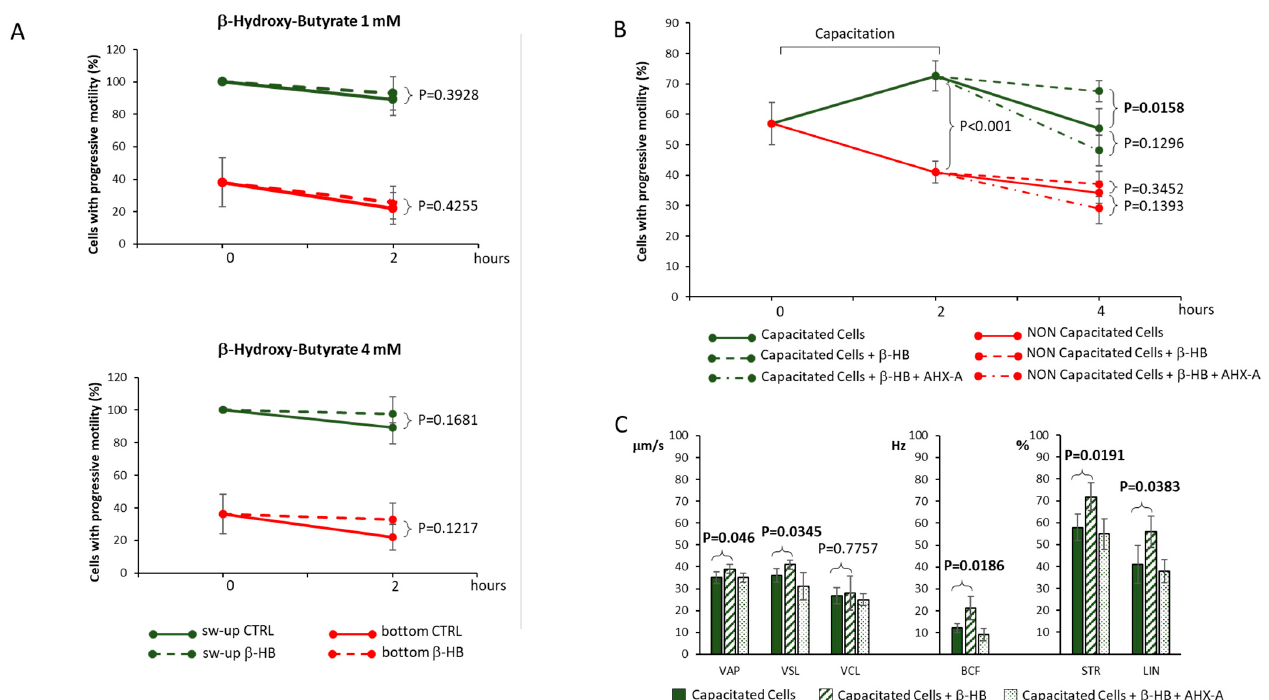
Figure 1. ( A ) Effect of 2 h exposure to 1 mM or 4 mM β -hydroxy-butyrate ( β -HB, dashed lines), on cell progressive motility, in sperm cells from normozoospermic subjects, isolated according to their highly migratory (sw-up, green lines) or low migratory (bottom, red lines) activity in a swim-up procedure. Continuous lines refer to β -HB-lacking controls. Results show the mean values of 4 independent experiments. ( B ) Effect of 2 h exposure to 4 mM β -HB (dashed lines) on cell progressive motility, in sperm cells undergone to capacitation (green lines) or non-capacitated controls (red lines). Point line traits refer to experimental conditions involving exposure to β -HB and the succinyl-CoA transferase inhibitor aceto-hydroxamic acid (AHX-A). ( C ) Sperm motility parameters, evaluated with a Sperm Class Analyzer (CASA), in capacitated sperm cells maintained for 2 h in capacitating medium, in capacitating medium with the addition of 4 mM β -HB, or in capacitating medium with the addition of 4 mM β -HB and AHX-A. CASA parameters included average path velocity (VAP), straight-line (rectilinear) velocity (VSL), sperm curvilinear velocity (VLC), beat-cross frequency (BFC), straightness (STR as VSL/VAP), and linearity (LIN). Results show the mean values of 4 independent experiments. Significance: P levels between indicated conditions are reported.